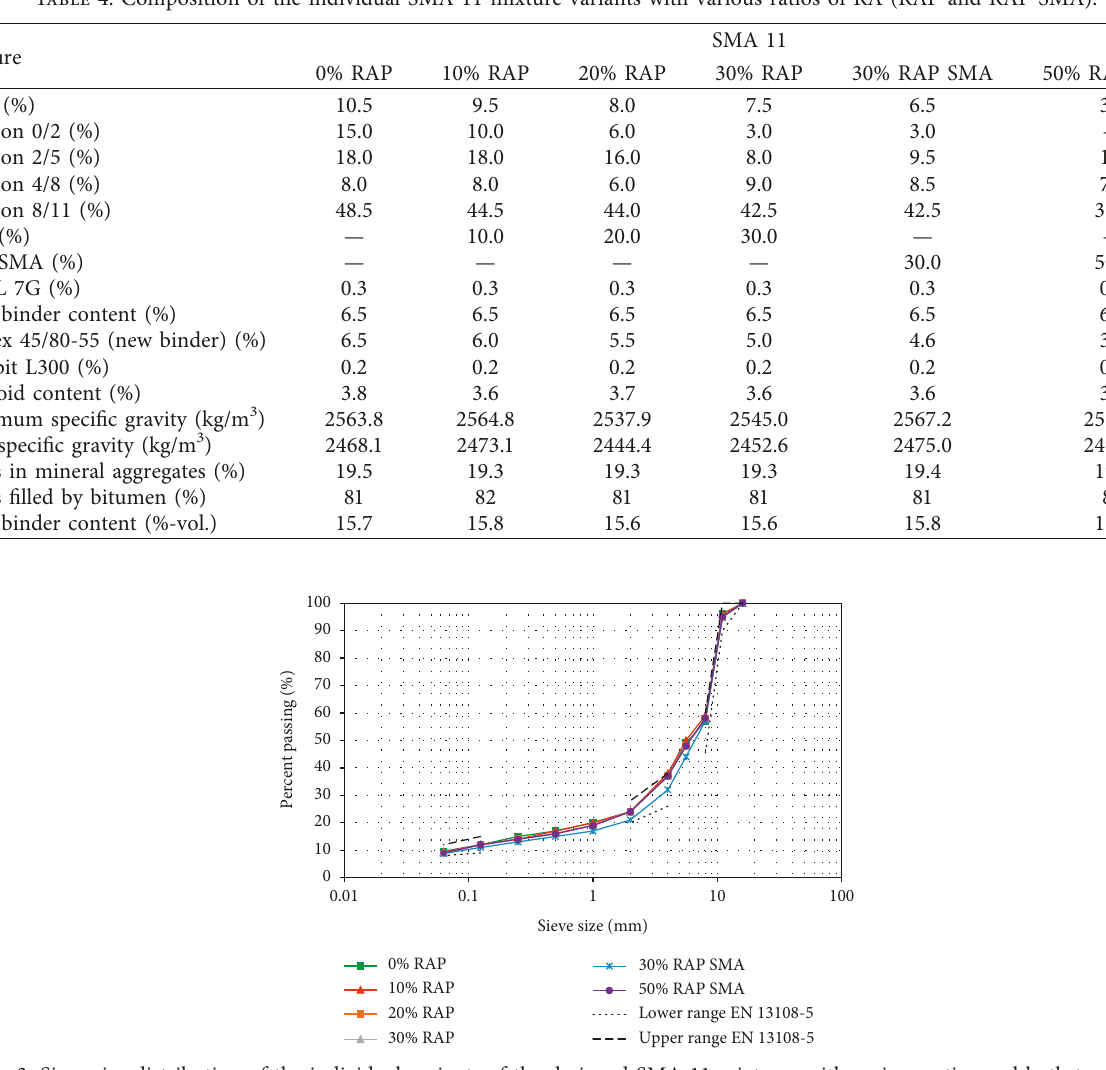
Table 4: Composition of the individual SMA 11 mixture variants with various ratios of RA (RAP and RAP SMA).